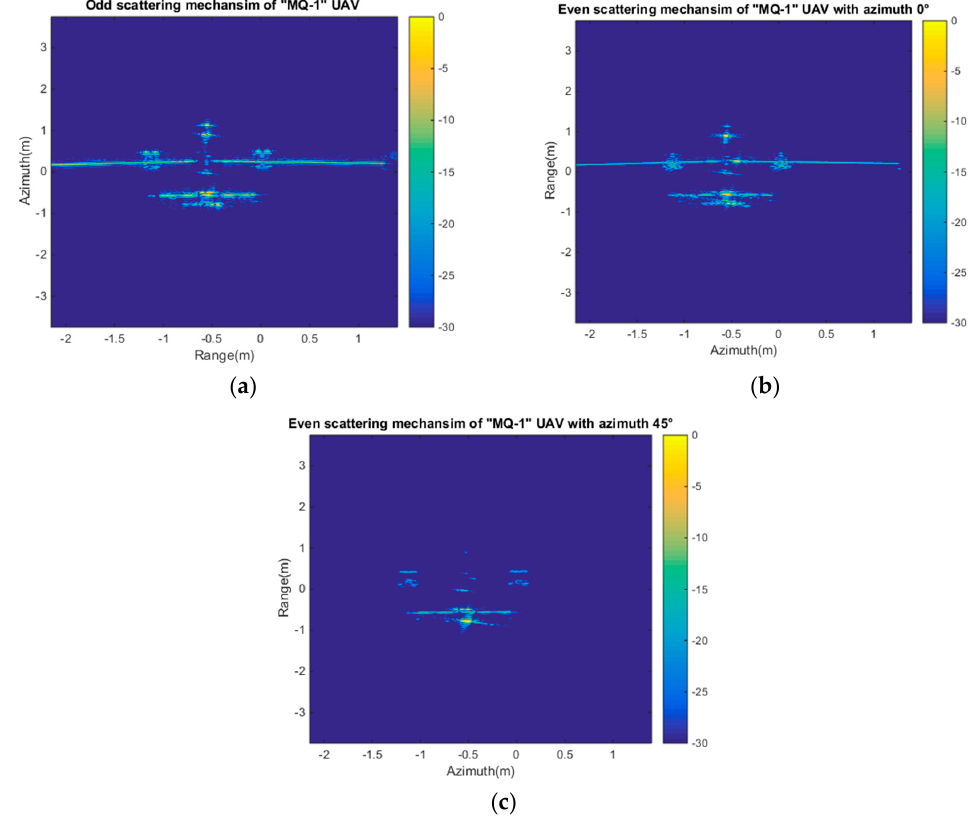
Figure 10. The Pauli decomposition of “MQ-1” UAV with an azimuth of 0°. ( a ) Odd scattering mechanism of “MQ-1” UAV; ( b ) Even Scattering mechanism with an azimuth of 0° of “MQ-1” UAV; ( c ) Even Scattering mechanism with an azimuth of 45° of “MQ-1” UAV.